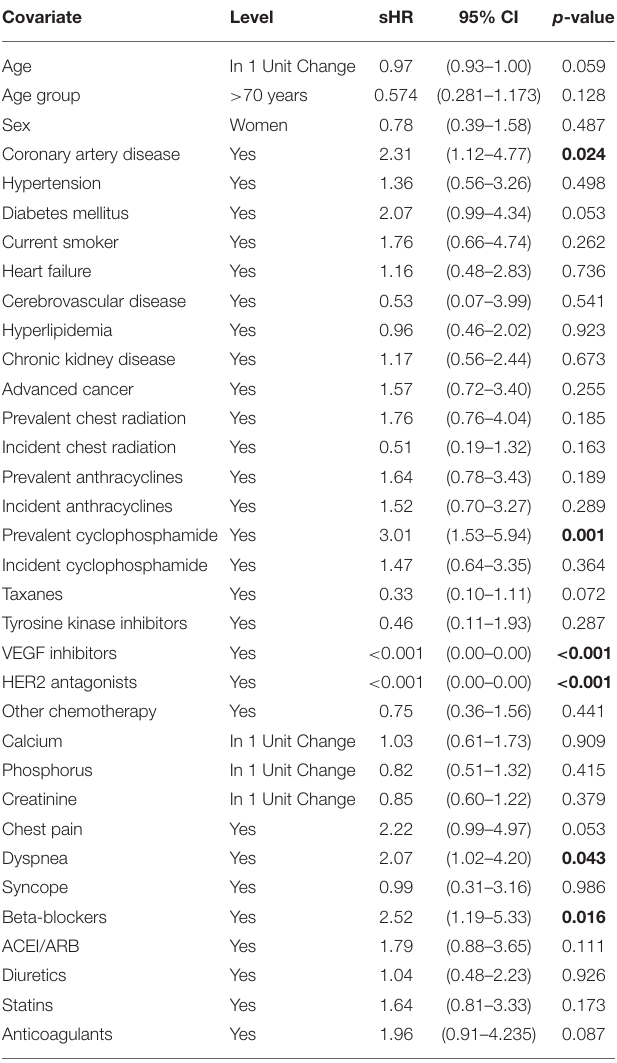
TABLE 2 | Univariate Fine-Gray model, aortic stenosis progression as an event of interest. Covariate